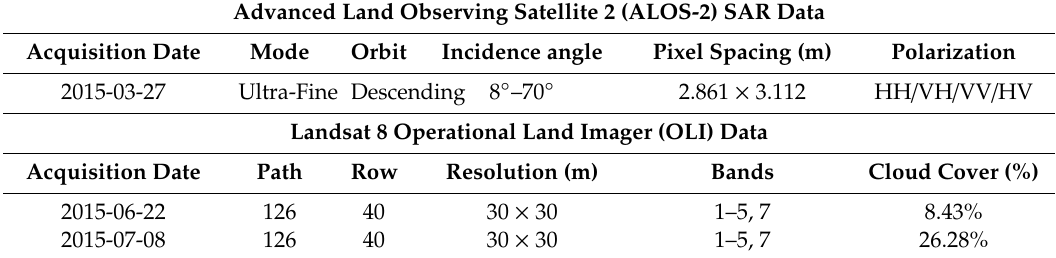
Table 1. Parameters of Advanced Land Observing Satellite (ALOS) 2 and Landsat 8 operational land imager (OLI)